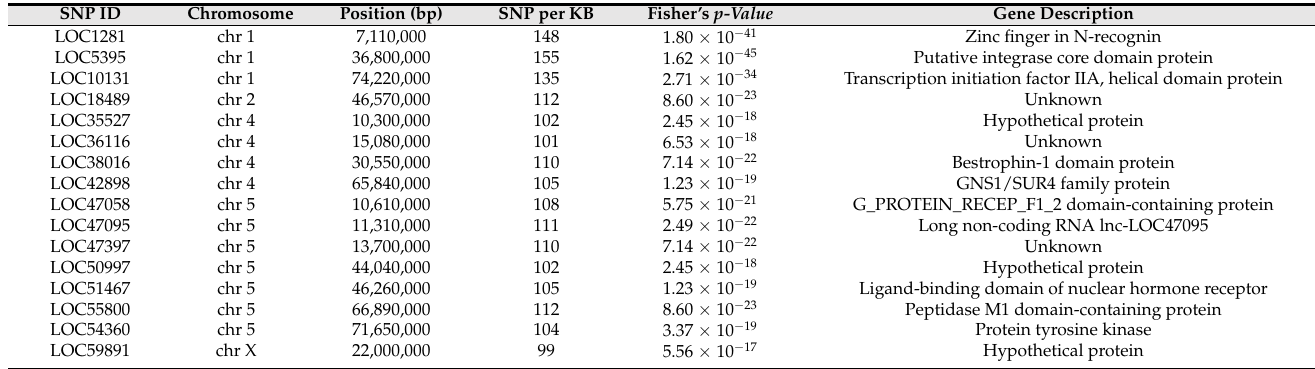
Table 1. Genome-wide SNP analysis using whole-genome sequencing of adult male H. contortus and the identified candidate genes putatively associated with vaccine